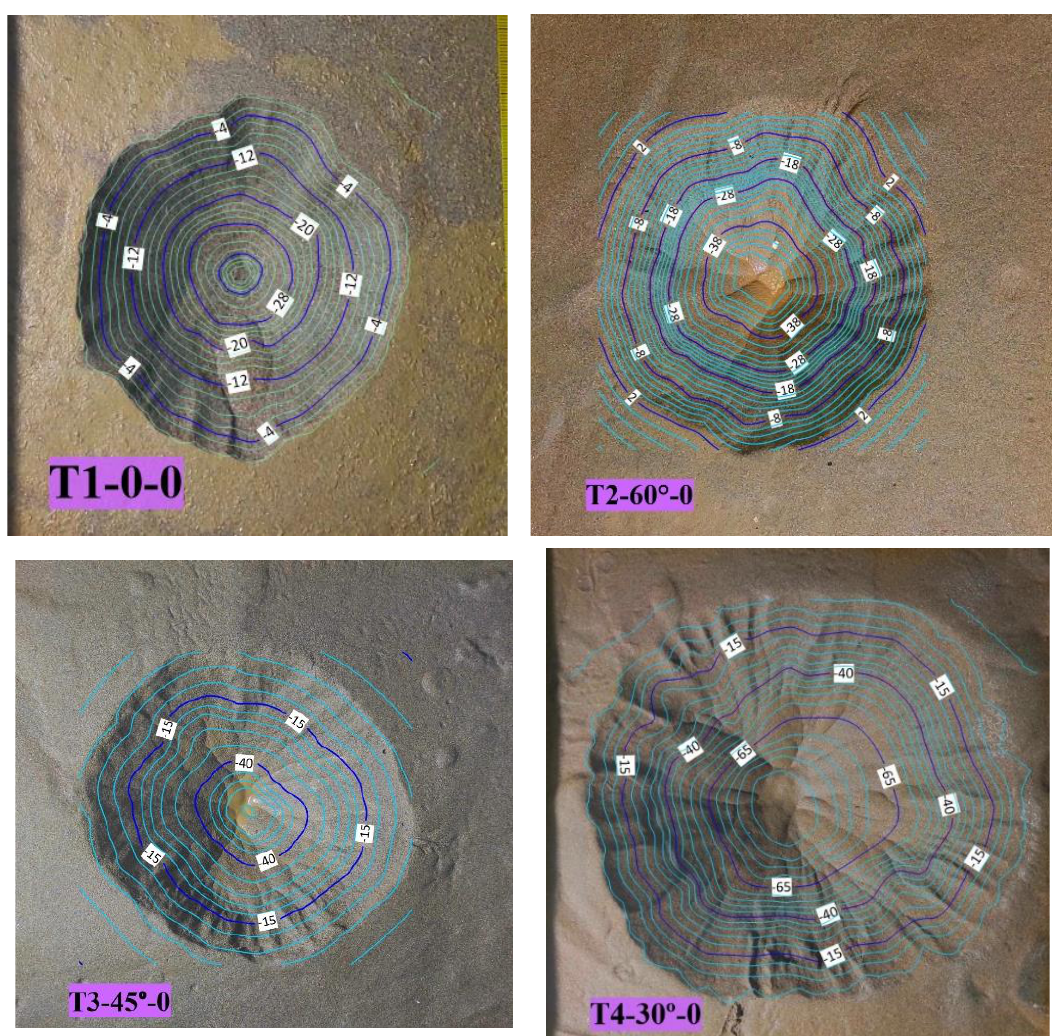
Figure 8. The effects of fan blade angles on the geometric properties of the scour hole for (1) T10-0: sample siphon; and (2) T2-60°-0, T2-45°-0; T2-30°-0: siphon with fan blades. In addition, by using the fan blades with a 30° angle, the maximum scour hole depth and diameter increased by 206% and 200%, respectively. Moreover, the scour hole depth and diameter increased by 137% and 135%, respectively, when the fan blade angle was 45°, and by 112% and 114% when the angle was 60°.